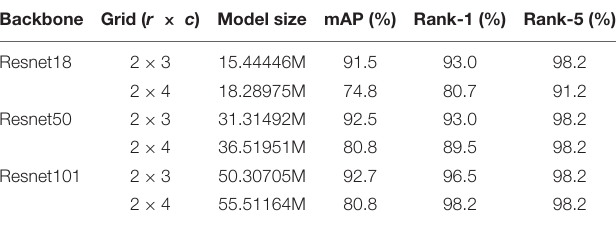
TABLE 4 | The performance of pyramidal feature fusion model (PFFM) with different division